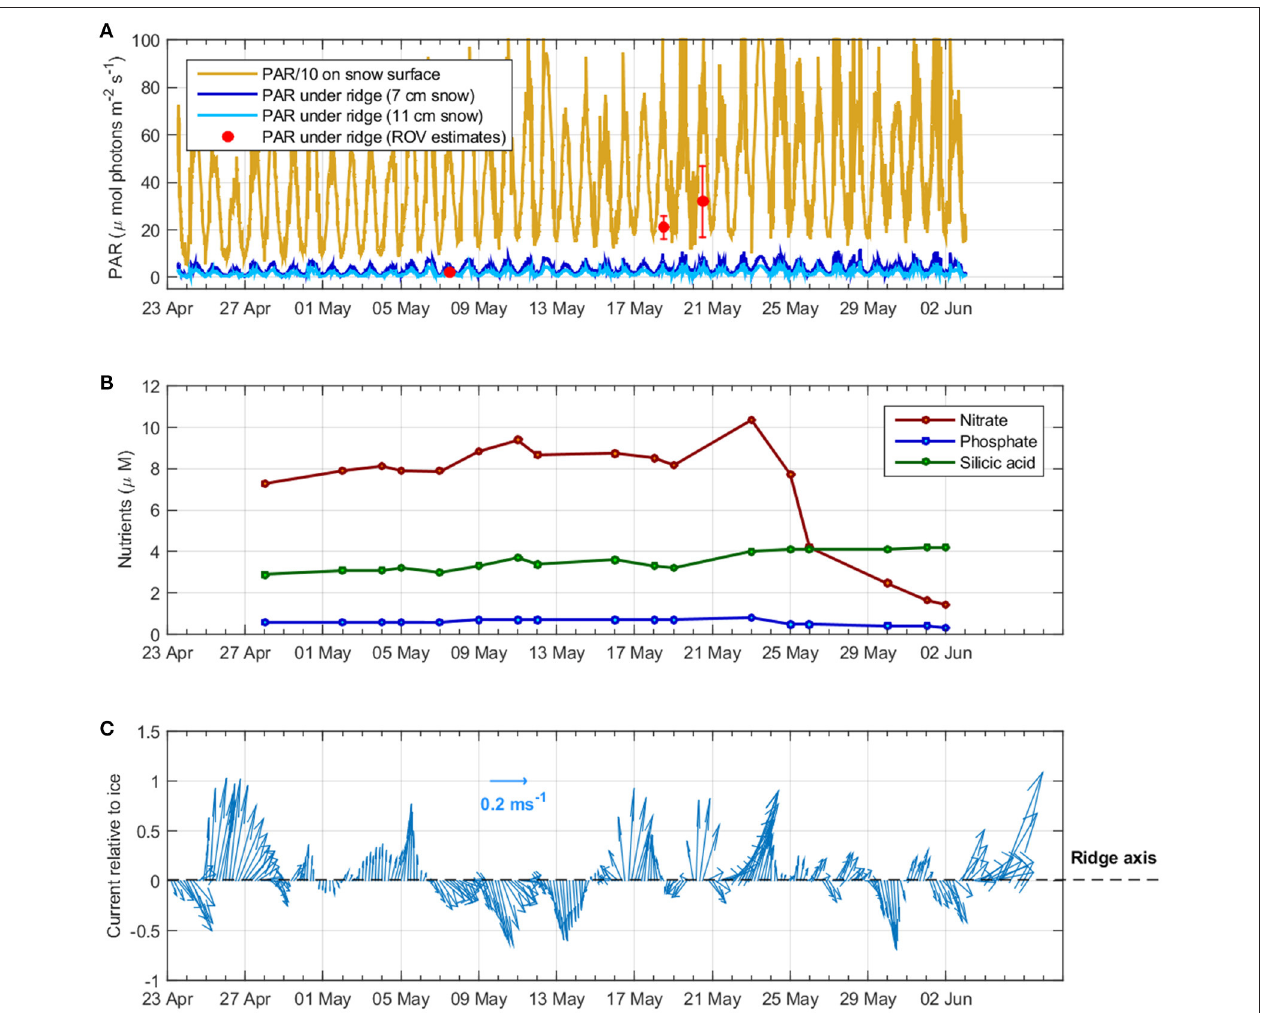
FIGURE 5 | Overview of the conditions during Floe 3 with time series of (A) incoming Photosynthetically active radiation (PAR) measured above the ice (yellow) and calculated below the ridge for two snow thicknesses (dark blue: 0.07m and light blue: 0.11m) and the ice ledge thickness on 31 May. The red dots represent average and standard deviation of ROV measurements performed on 7, 18, and 20 May; note that PAR values above the ice (yellow) have been scaled down by a factor of 10 for clarity purposes; (B) Nutrient concentrations (nitrate, phosphate, and silicic acid) at 5m depth below the ice; (C) Ocean current speed relative to the ice depicted by the arrows size and direction relative to the ridge axis at 23m depth depicted in the y-axis (from vessel-mounted